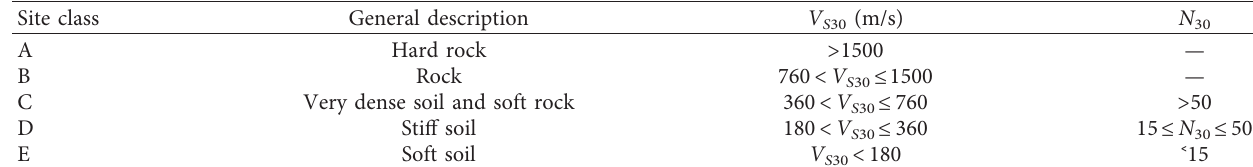
Table 2: Definition of NEHRP site classes in terms of V